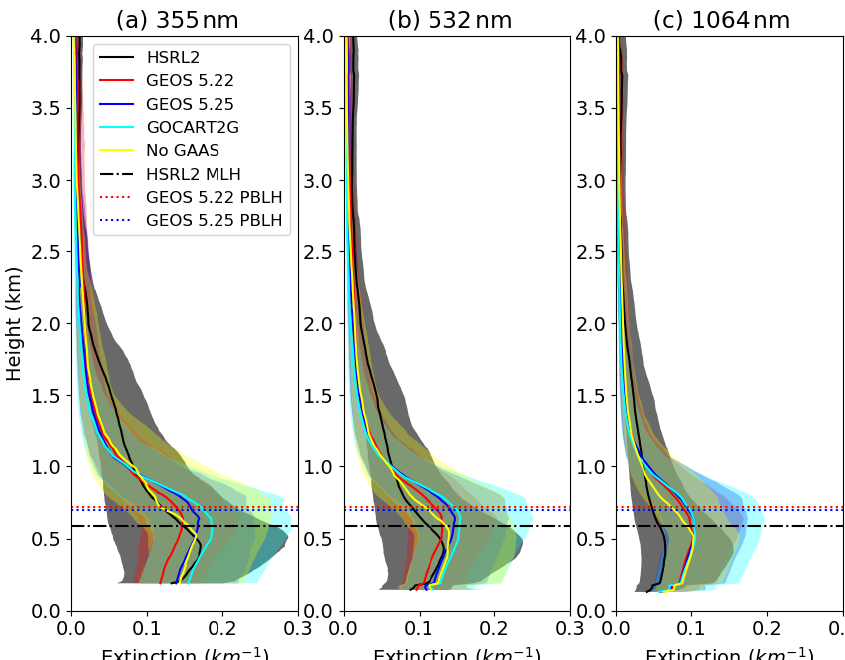
Figure 4. Median extinction at (a) 355nm, (b) 532nm, and 1064nm during all research flights from the HSRL2, GEOS 5.22, GEOS 5.25, GOCART2G, and GOCART2G without aerosol assimilation (No GAAS). Profiles are shaded between the 25th and 75th percentiles. Mixed layer height (MLH) from the HSRL2 and planetary boundary layer (PBL) height in GEOS are added for reference as dashed lines. Note that PBL height for GOCART2G is the same as GEOS 5.25.